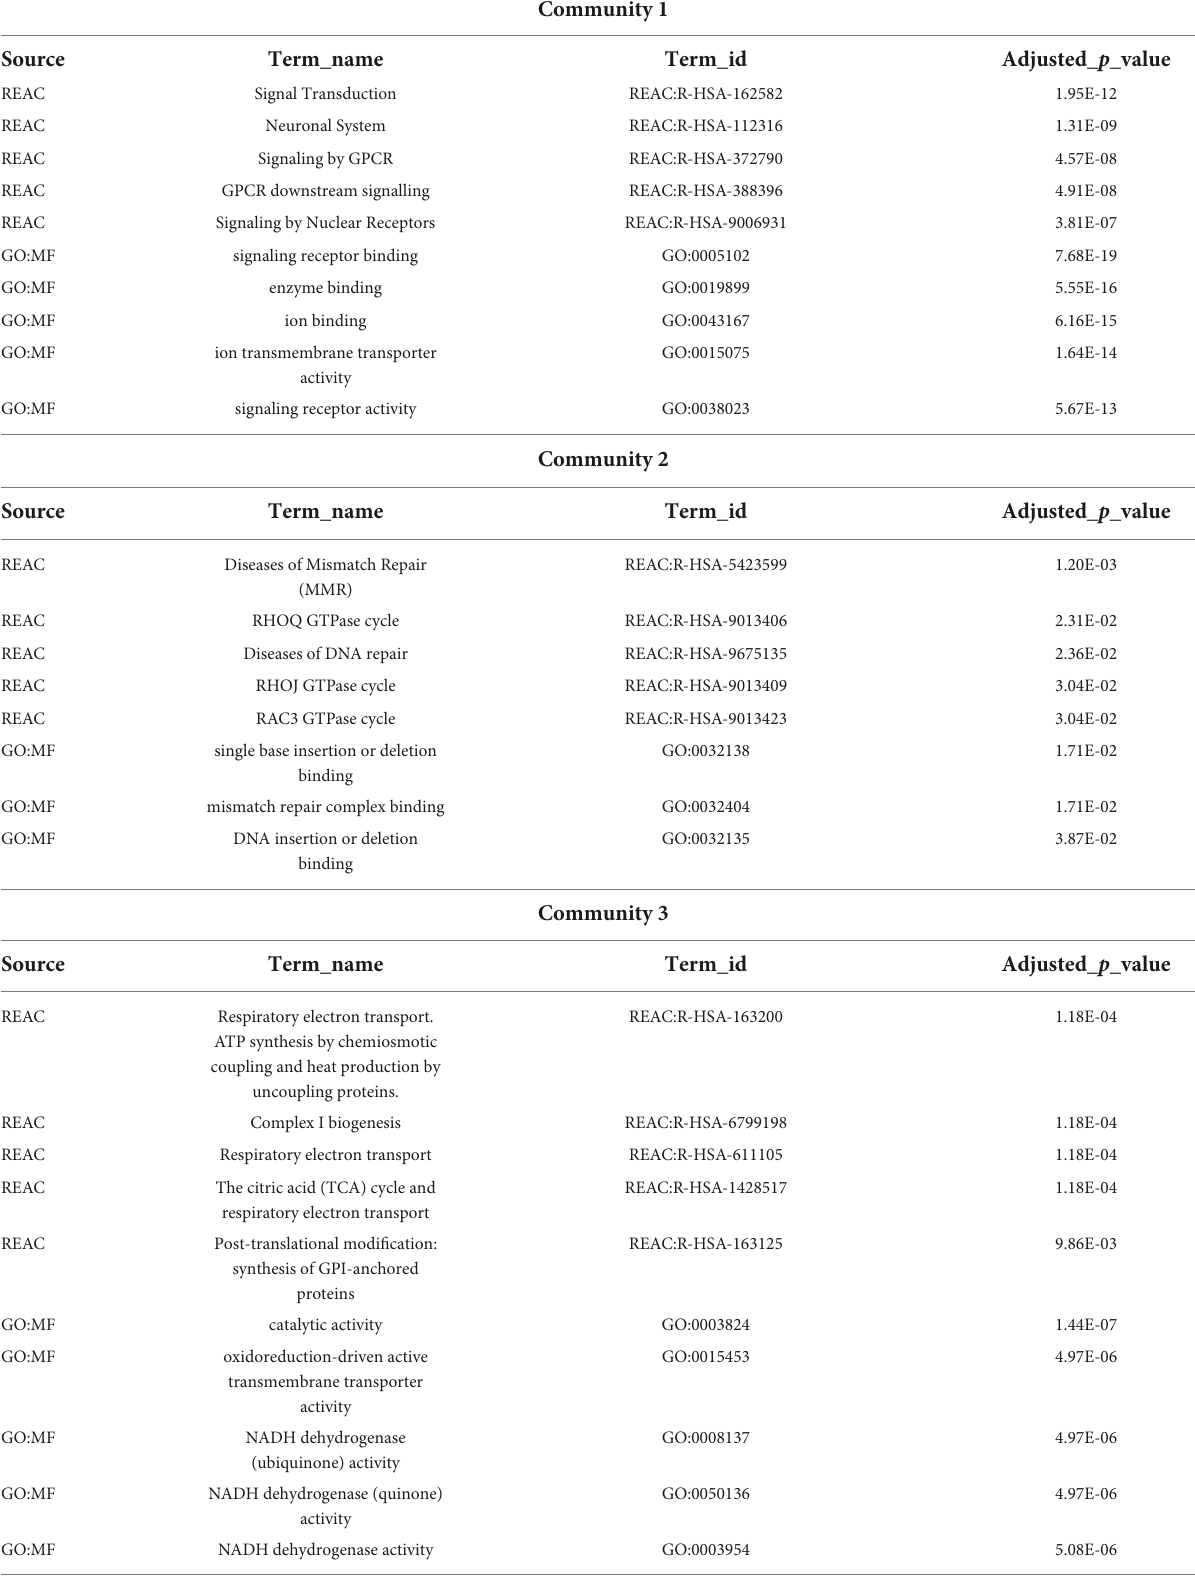
TABLE 2 Top five Gene Ontology molecular functions and Reactome pathways enrichment for communities’ exclusive genes. Community